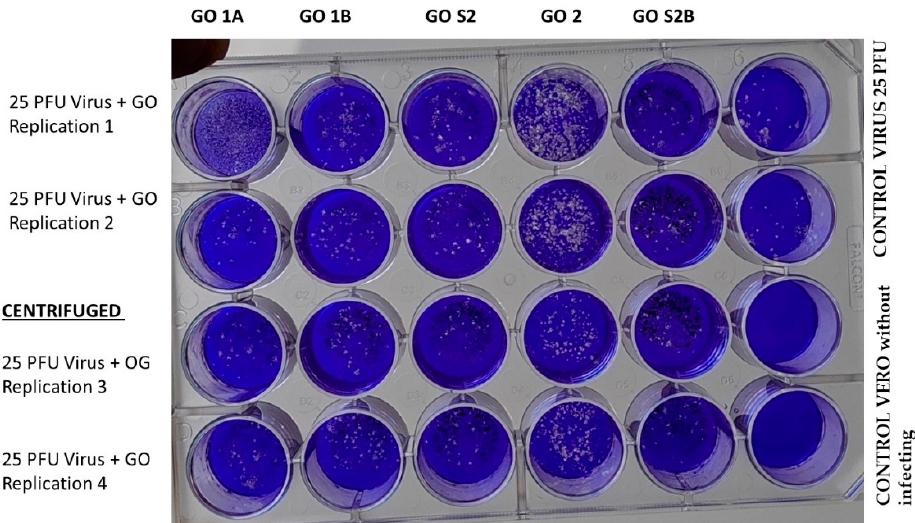
Figure 5. SARS-CoV-2 virus plating assay in VERO cells using 400 µg/mL of the centrifuged and non-centrifuged OG, OG, + virus blend.